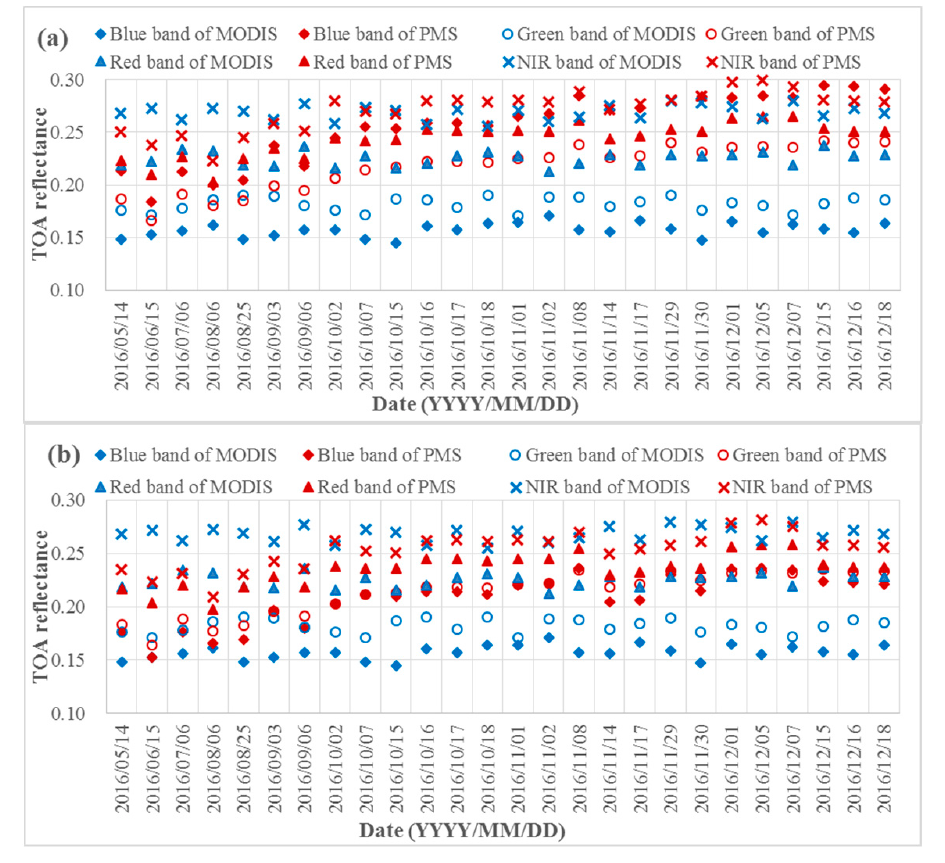
Figure 4. Comparison of the top-of-the atmosphere (TOA) reflectance between GF-4/PMS and Terra/MODIS. ( a ) Laboratory calibration. ( b ) Vicarious calibration.